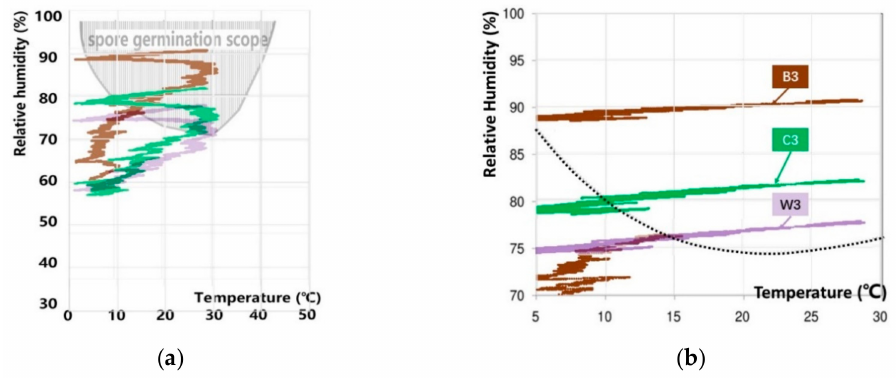
Figure 25. Mold growth risk evaluation of the wall cells (B3, C3 and W3): ( a ) fungal spores’ germination scope (all the months); ( b ) Aspergillus penicilliodes’ growth risk evaluation during summer